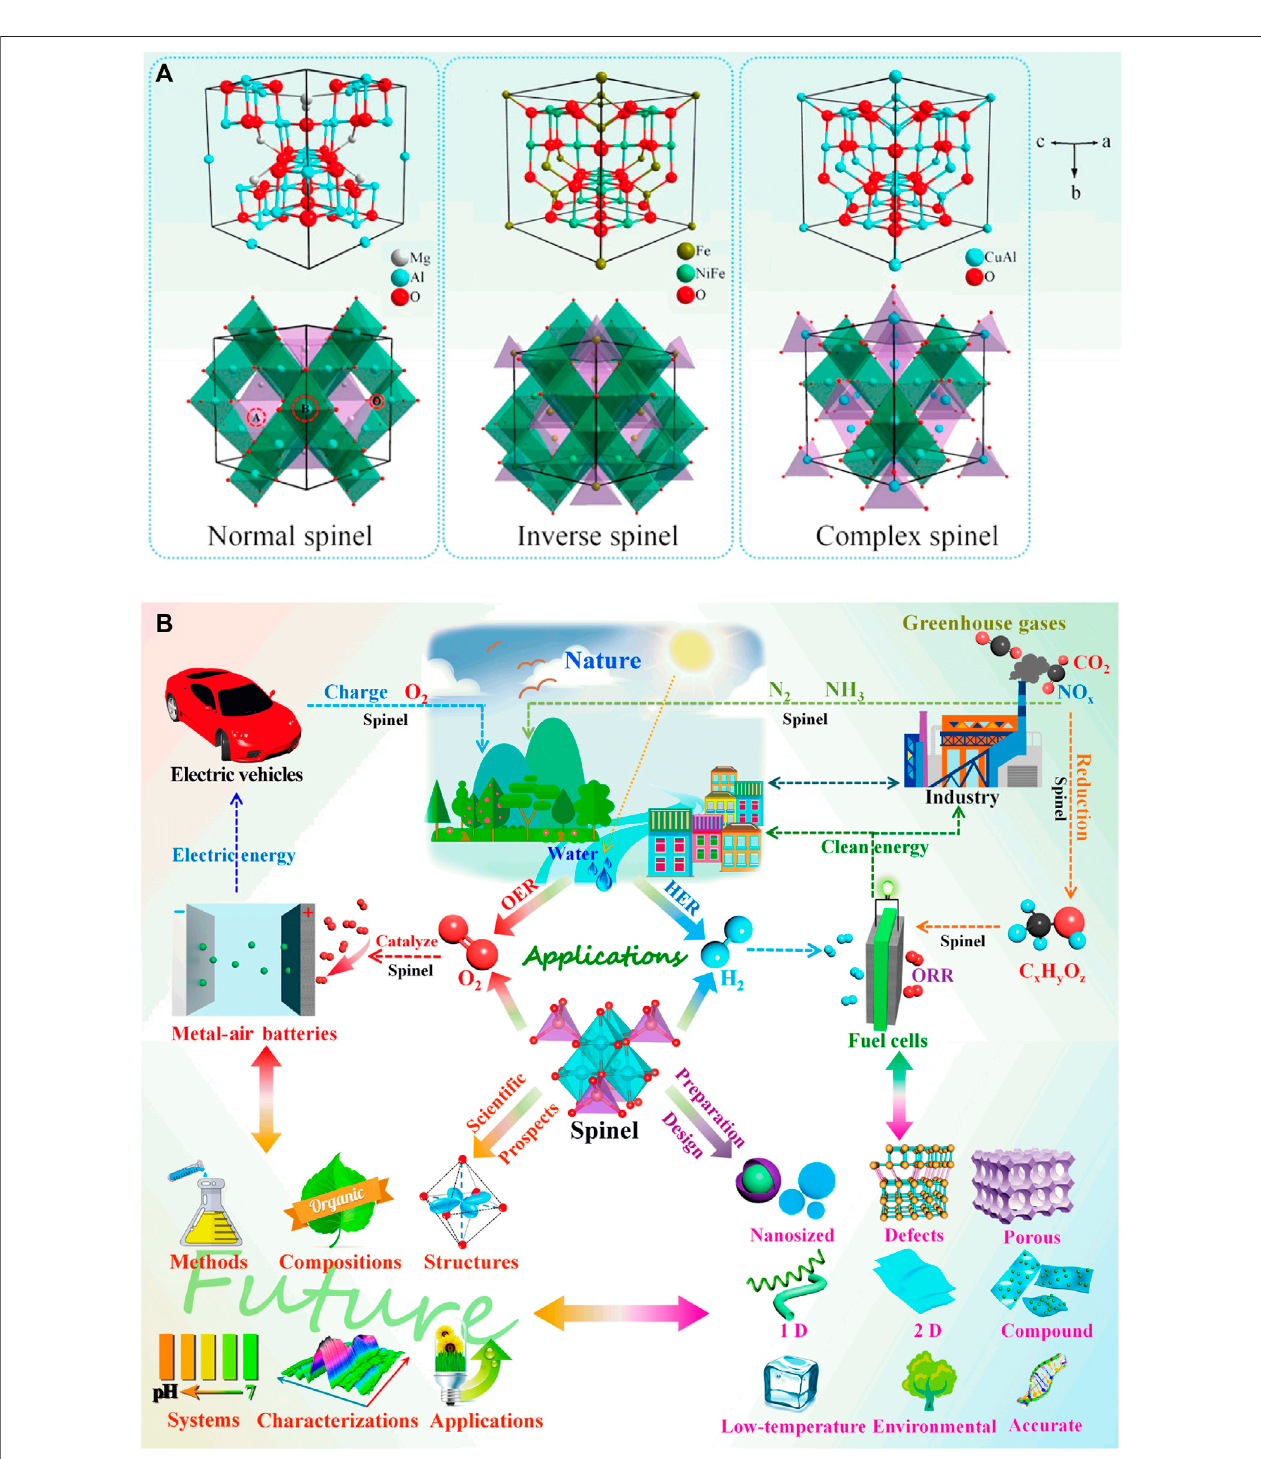
FIGURE 1 | (A) Illustration of the structures of spinel, (B) future development of spinel compounds, applications, preparations, and fundamental challenges. Reproduced from Zhao et al. (2017) with permission from the American Chemical Society.